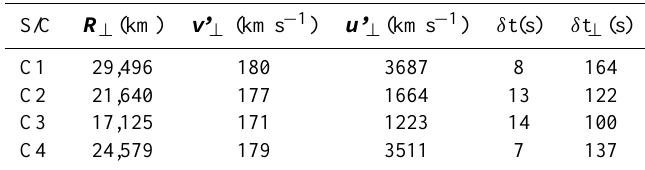
Table 2. R ⊥ is the perpendicular displacement between the Signature 1 flux rope axis and TC-1; v’ ⊥ is the observed plasma velocity as projected on to the displacement vector; δ t is the observed difference between the time of flux rope encounter at the Cluster spacecraft and TC-1; δ t ⊥ is R ⊥ / v’ ⊥ , the required time difference between observation of Signature 1 and Signature 2 for a rope to propagate at the observed speed; and u’ ⊥ is the required propagation speed for a flux rope to travel from Cluster to TC-1 in δ t. The measured velocities are too low to carry the Signature 1 flux rope to TC-1 in the observed times.